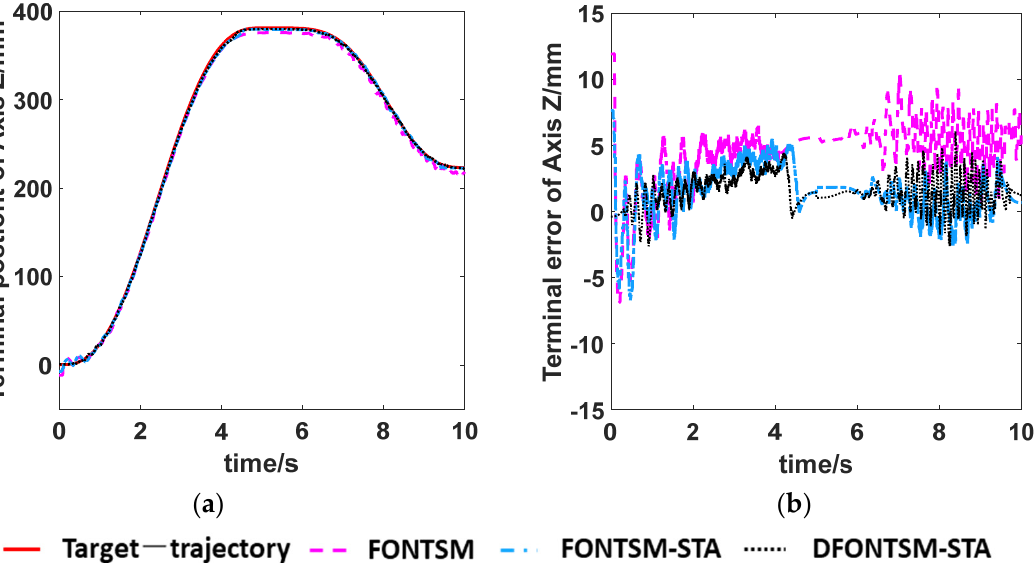
Figure 17. Terminal trajectory and its tracking error. ( a ): terminal trajectory on the Z axis; ( b ): terminal tracking error on the Z axis.